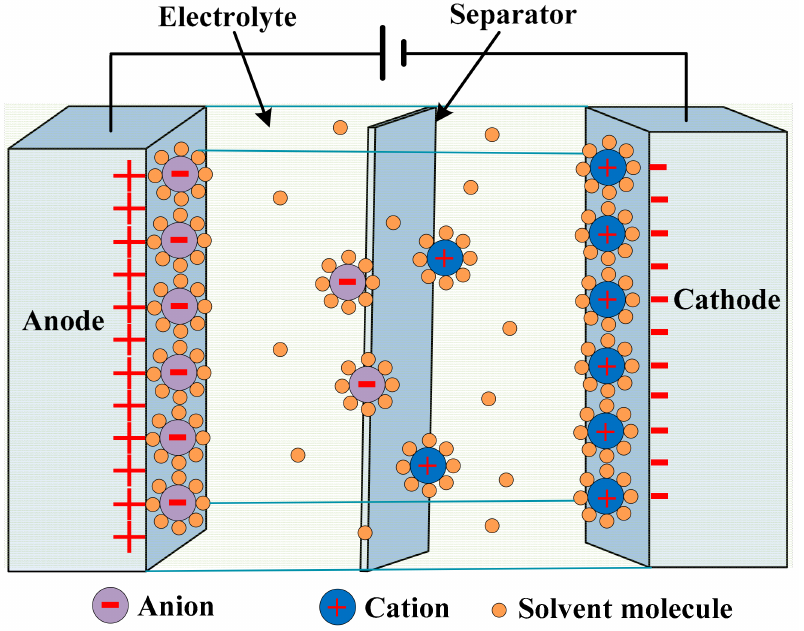
Figure 12. Structure of electrostatic